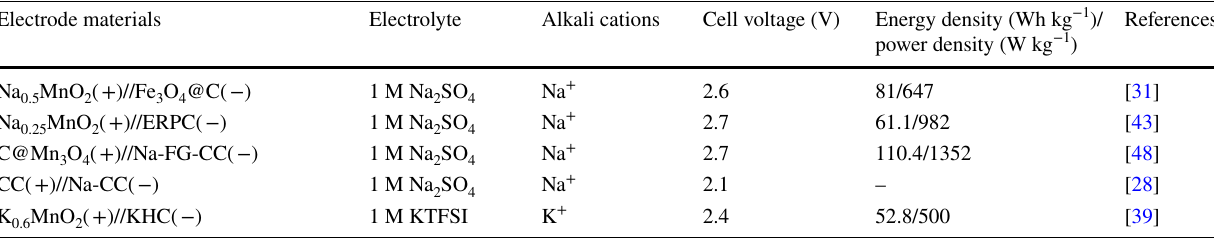
Table 1 The comparison of recent works about doping alkali cations in the field of high‑voltage aqueous SCs Electrode materials